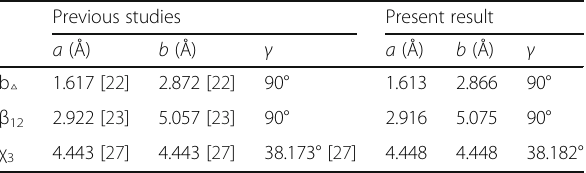
The results for the buckled triangular, β 12 , and χ 3 boron sheets are